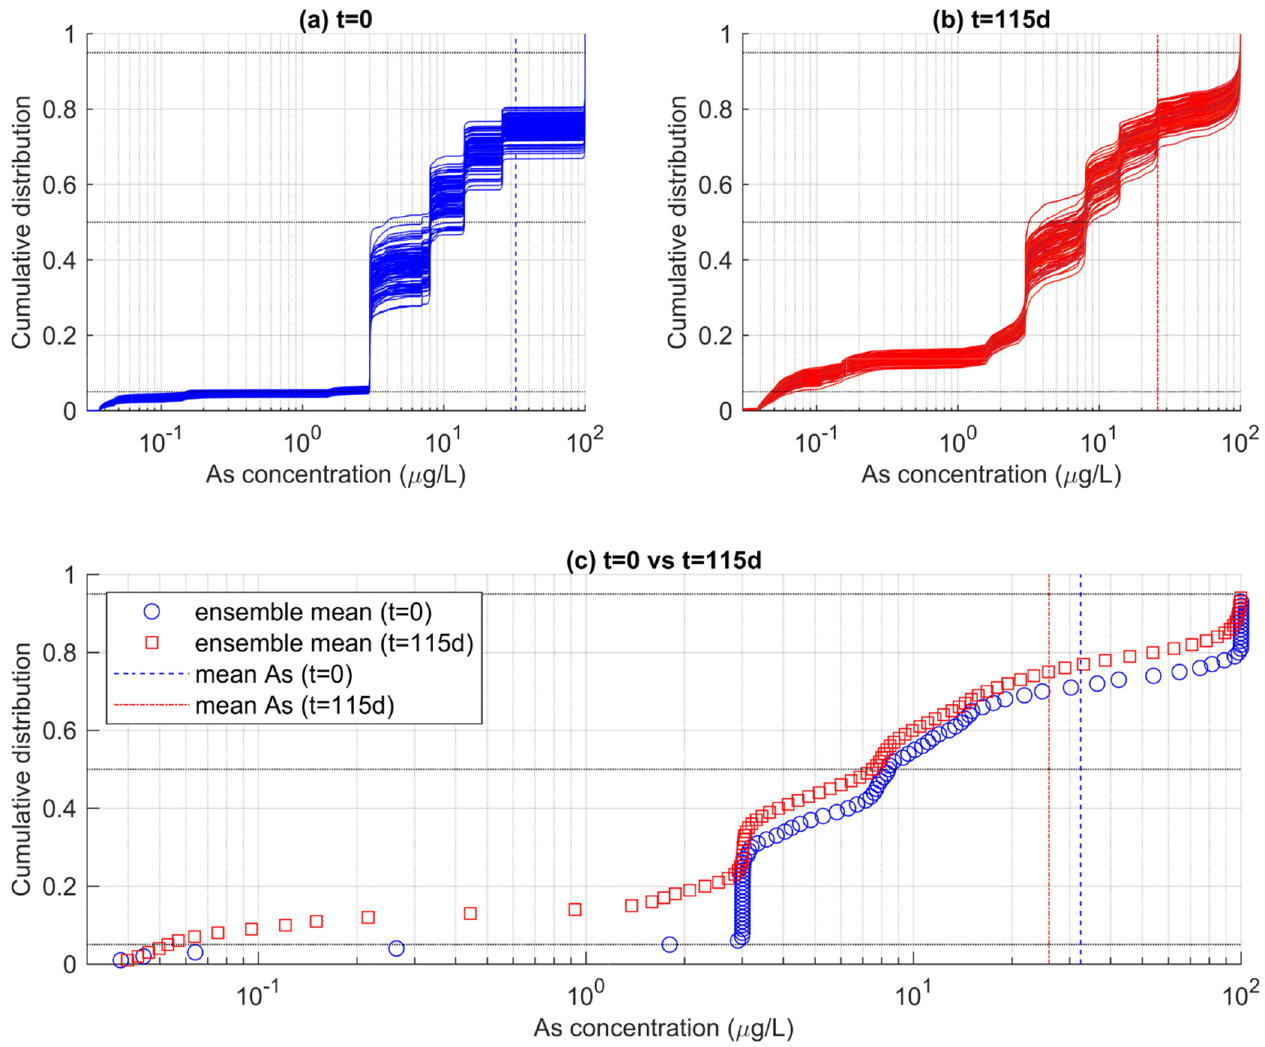
Figure 8. Ensembles of ecdfs of As concentration calculated for the entire aquifer ( a ) at the beginning of the simulations (t = 0) and ( b ) at the end of the simulations (t = 115 d). In ( c ), the ensemble-mean ecdfs are reported, suggesting a time-dependent change in the probability that As does not exceed a specific threshold.